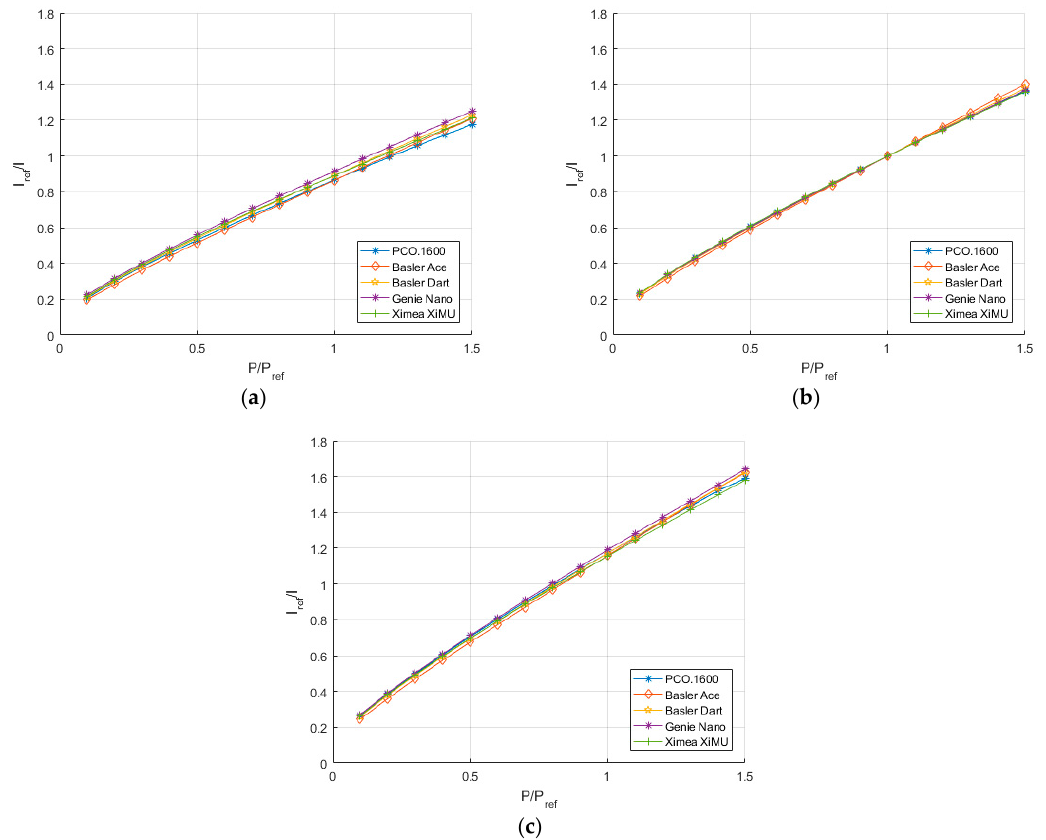
Figure 17. Comparison of calibration plots between cameras at ( a ) 273K, ( b ) 293K and ( c ) 313K.